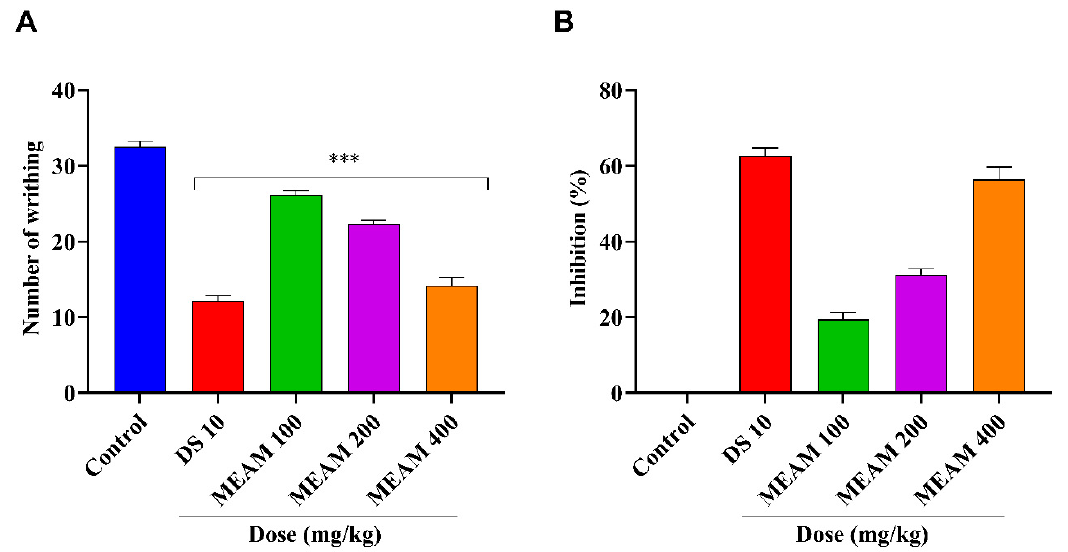
Figure 4. Analgesic effect of methanol extract of A. montanum (MEAM) and diclofenac sodium (DS): ( A ) Acetic acid-induced abdominal writhing; and ( B ) percent inhibition. Values are presented as mean ± S.E.M. (n = 6); *** p < 0.001, compared with vehicle control (Dunnett’s test).